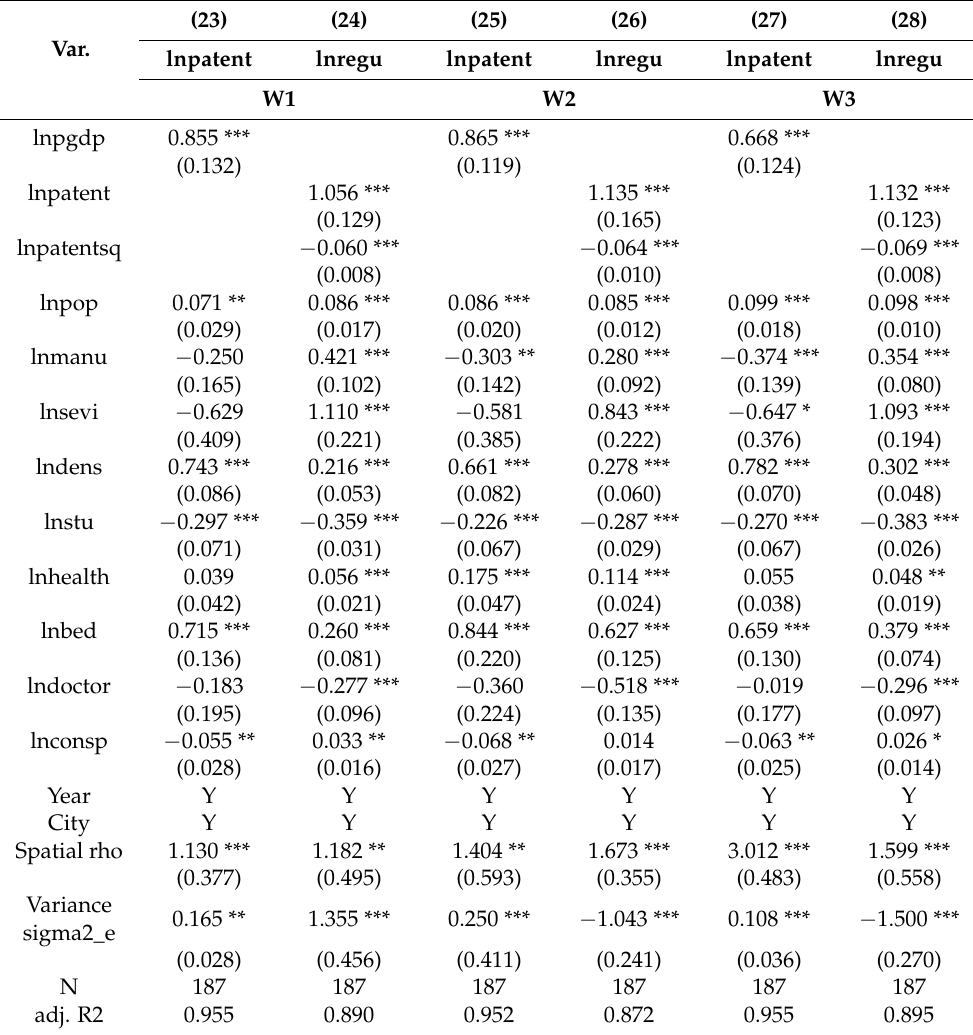
Table 5. The technological innovation effect test.